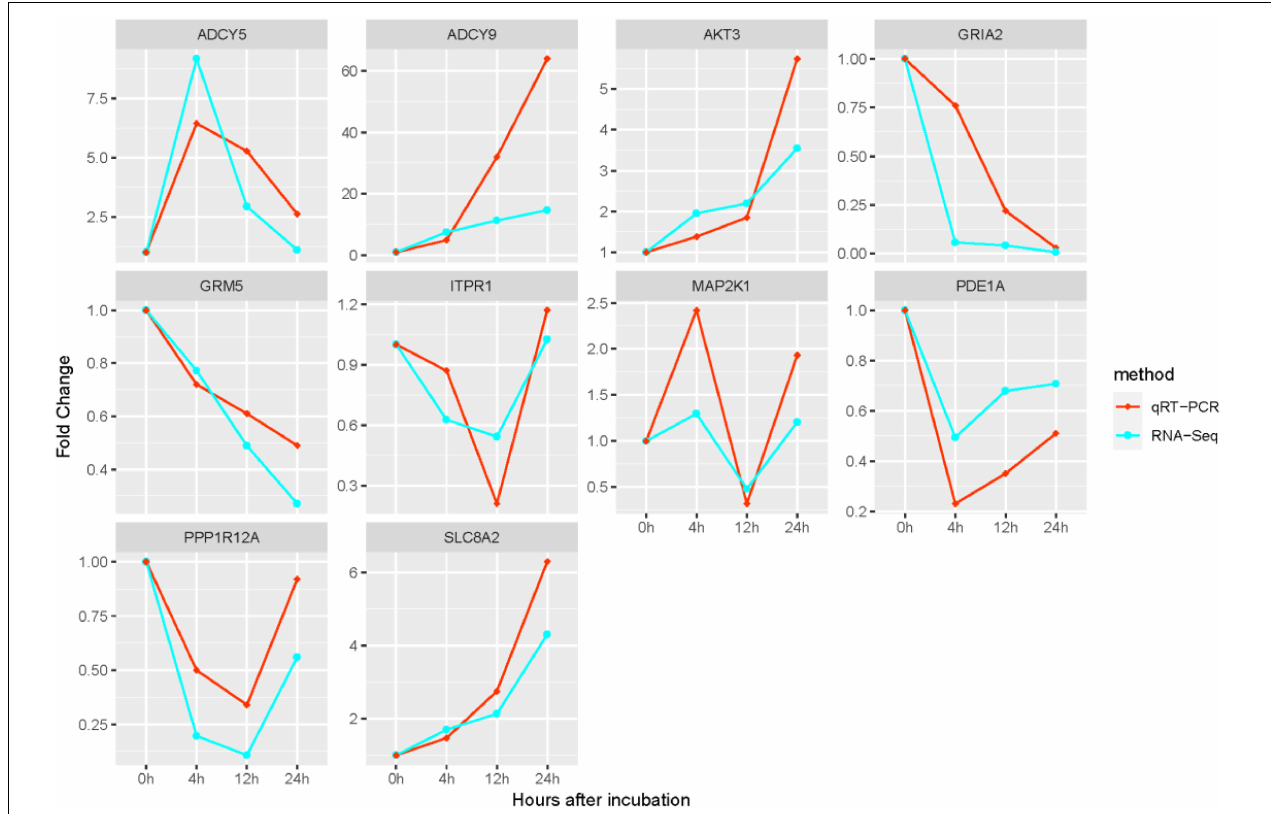
FIGURE 7 | Comparison of expression of 10 hub genes between qRT-PCR and RNA-Seq results. The transcript expression levels of the selected DEGs were each normalized to that of the β -actin gene. The x -axis represents the growth time after hatching; the y -axis stands for fold